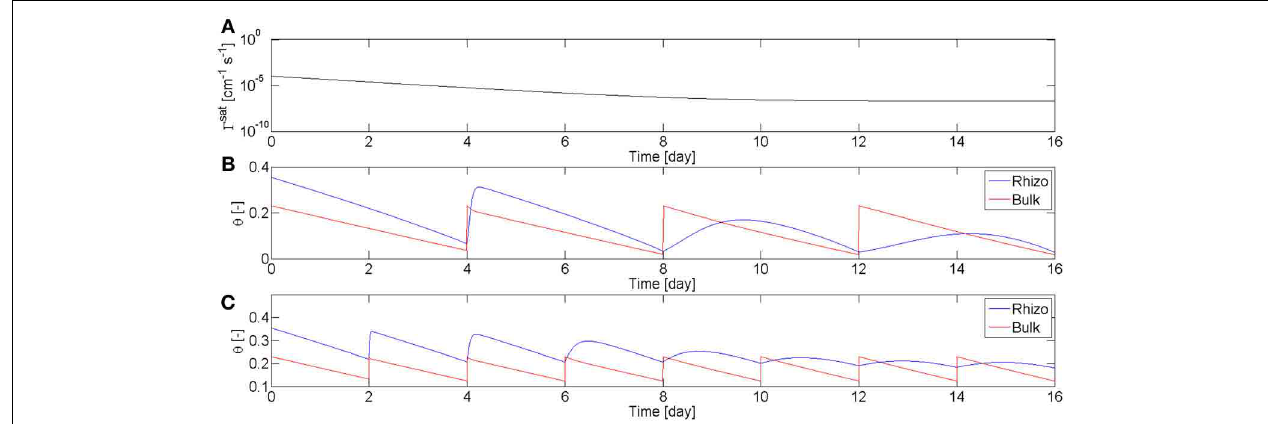
FIGURE 6 | Water content in rhizosphere (blue) and bulk soil (red) during drying and wetting cycles simulated using the model in Equation (2–5). (A) Coefficient of wetting rate of water saturated mucilage, (cid:4) sat , as a function of mucilage age according to Equation (4). (B) Simulation of the water content